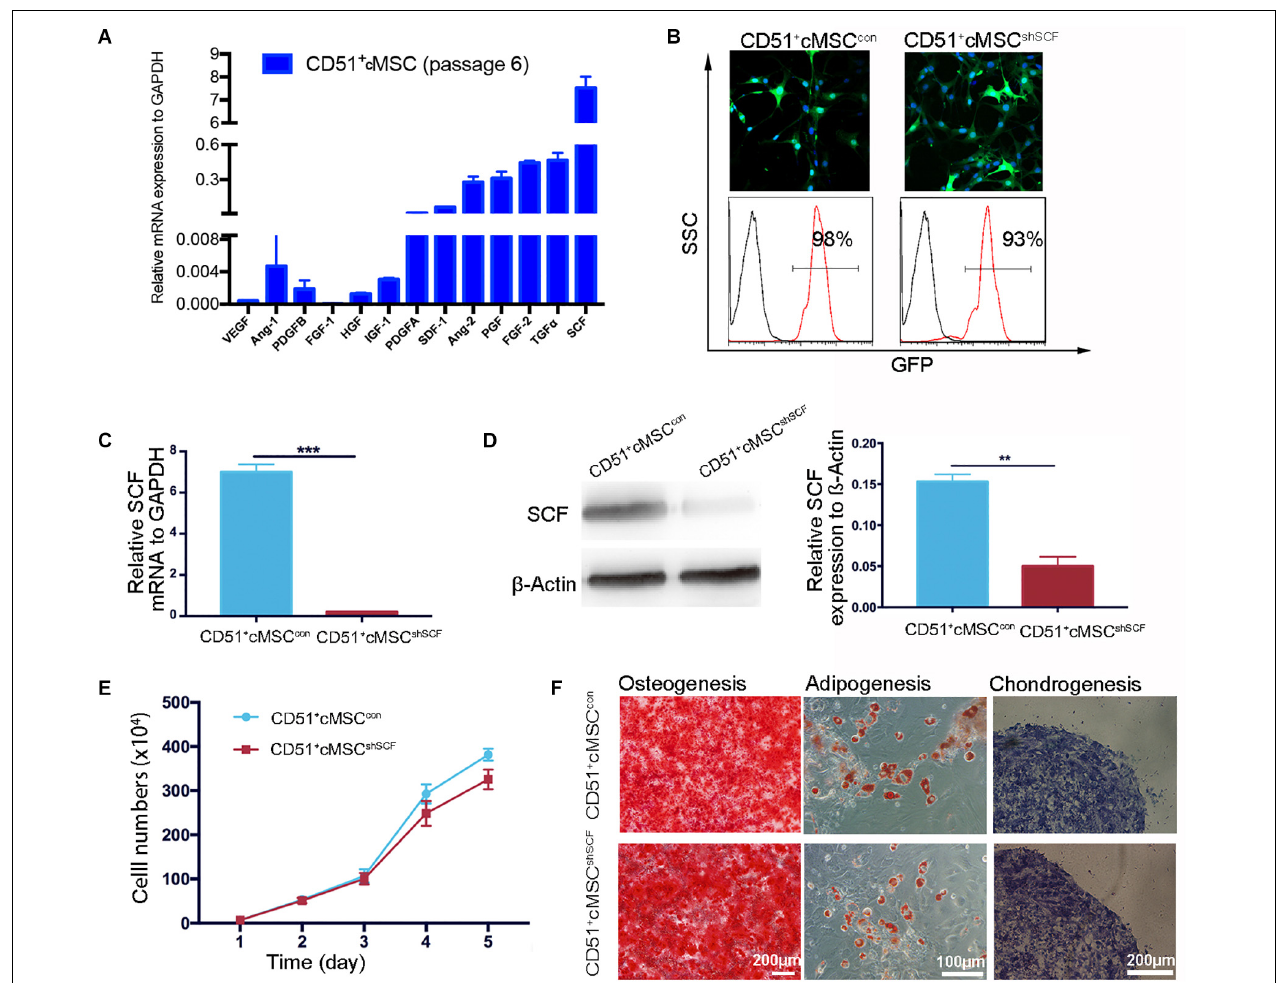
FIGURE 5 | Downregulation of functional SCF in CD51 + cMSCs. (A) Assessment of the angiogenesis-related mRNA expression in CD51 + cMSCs (passage 6) by qPCR; SCF showed the highest expression among the tested genes, n = 3. (B) Lentivirus infection efficiency was measured via GFP expression using a microscope and flow cytometry; CD51 + cMSC shSCF : the lentiviral vector carrying the shRNA; CD51 + cMSC con : the lentiviral carrying the mock vector. (C) Detection of SCF mRNA expression in lentiviral-infected cells using qPCR 72 h post infection, n = 3. (D) Estimation of SCF protein in lentiviral-infected cells using western blotting 4 days after infection, n = 3. (E) The proliferative curve of the cultured CD51 + cMSC shSCF and CD51 + cMSC con ; cells were in passage 8, n = 5. (F) Multipotent differentiation of CD51 + cMSC con and CD51 + cMSC shSCF , osteogenesis (Alizarin Red), adipogenesis (Oil Red O), and chondrogenesis (Alcian blue); scale bars have been marked in the figure. Data in all panels are presented as means ± SEM, ** P < 0.01 and *** P < 0.001.